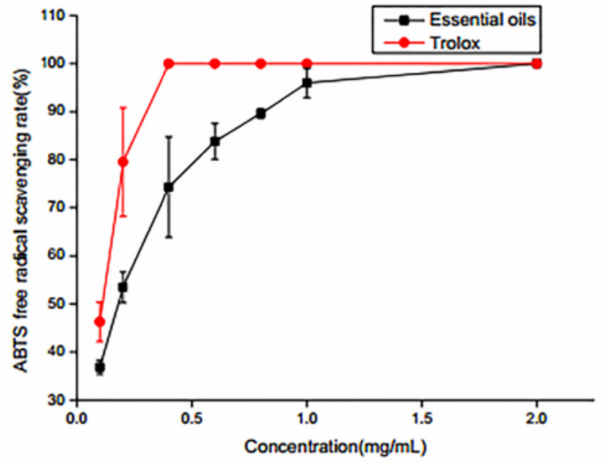
Figure 1. ABTS radical scavenging